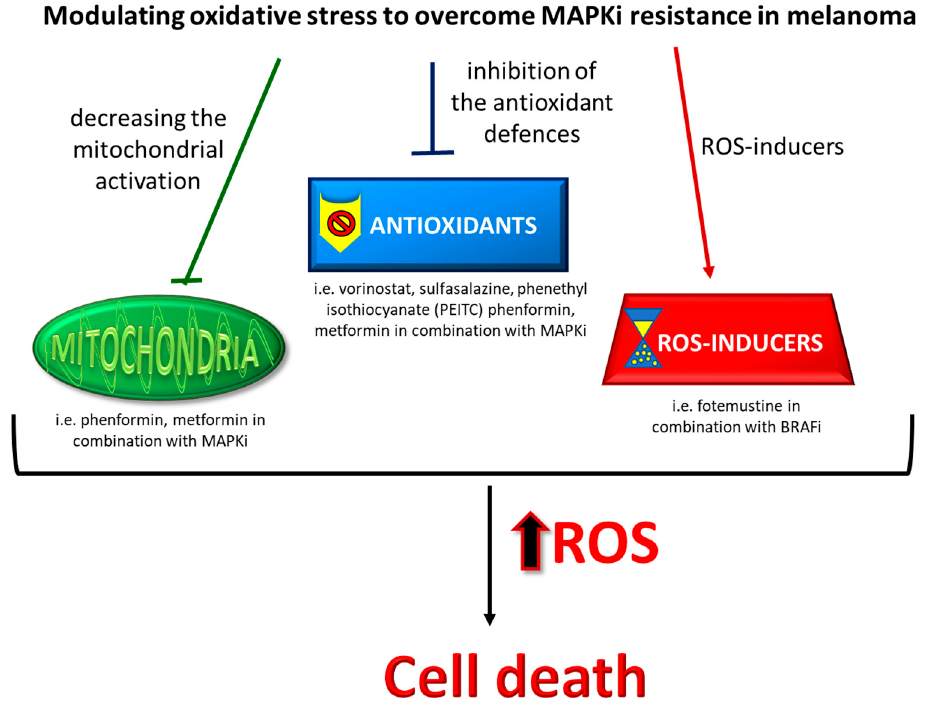
Figure 3. Modulating oxidative stress to overcome MAPKi resistance in melanoma. Three main ther- apeutical strategies able to modulate oxidative stress can be considered: (i) decreasing mitochondrial activation; (ii) inhibiting antioxidant defenses; (iii) further increasing ROS production. See Section 4.1 for full explanation.